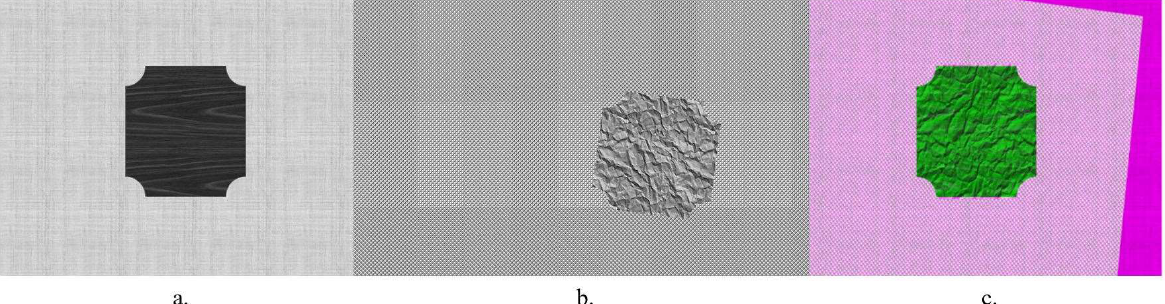
Figure 3. Registration pair by SSR: ( a ) is the simulated infrared image, ( b ) is the simulated polarized image, and ( c ) is the registration result.